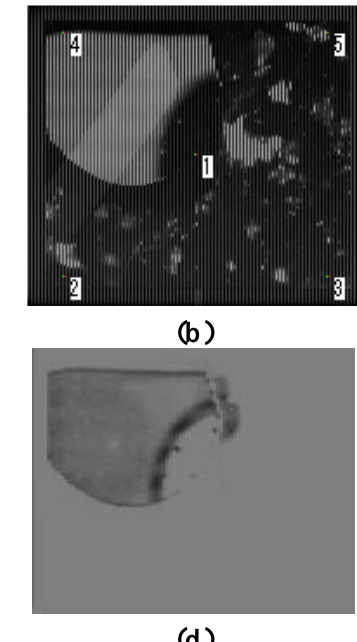
Figure 5. (a) Experimental setup; (b) as-captured image; (c) optical image; and (d) electric image captured by the optical and electric dual-image CMOS sensor (adapted from